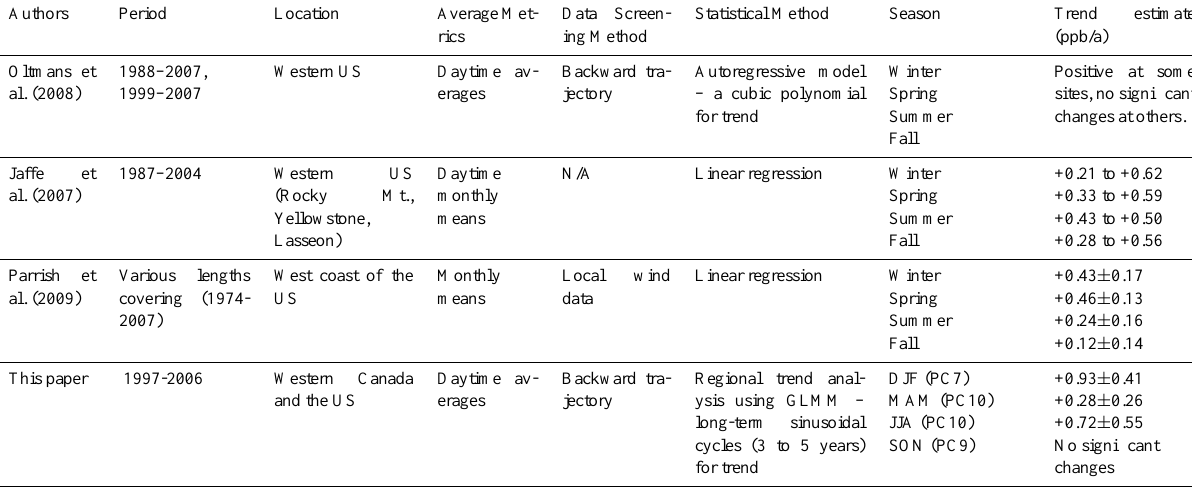
Table 3. A comparison of the statistical methods used and the baseline ozone trend estimates focusing on Western Canada and the Western US from three recent papers and this